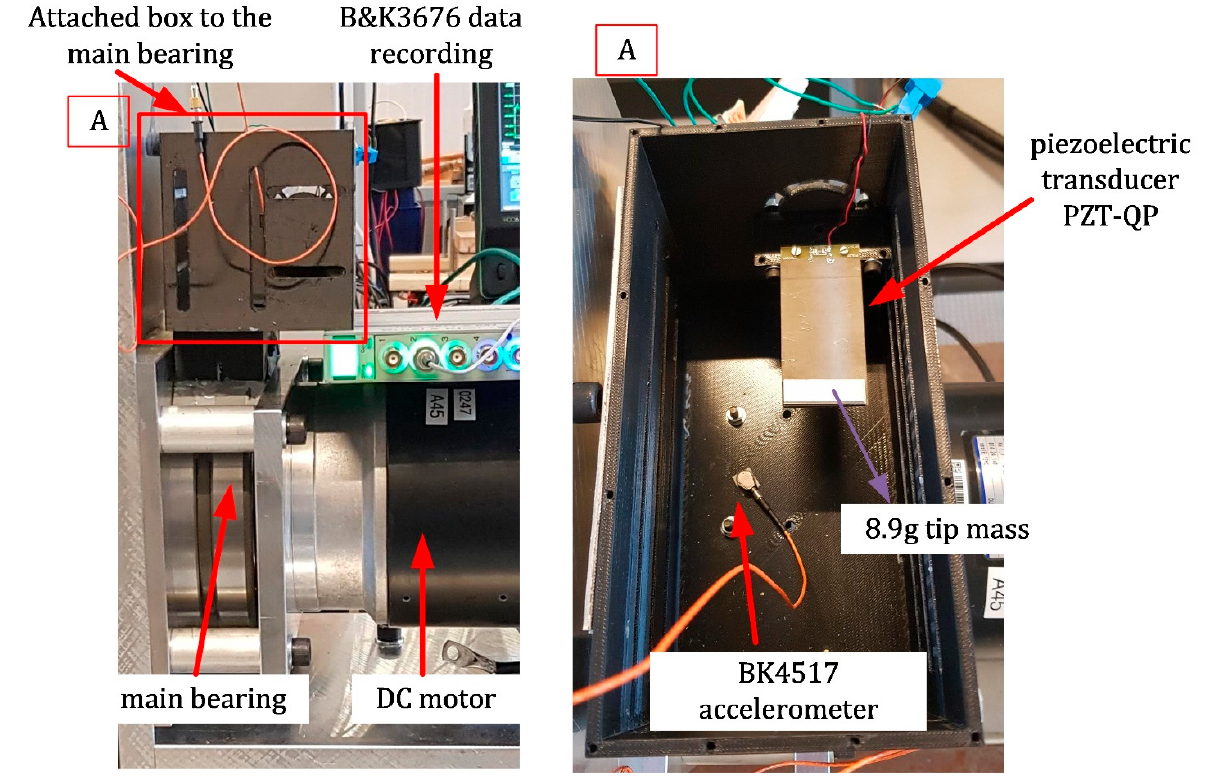
Figure 11. The pre-wired bimorph (PZT-QP) for the energy harvesting from the DC motor at different rotation speeds. A is the energy harvesting box in detail.